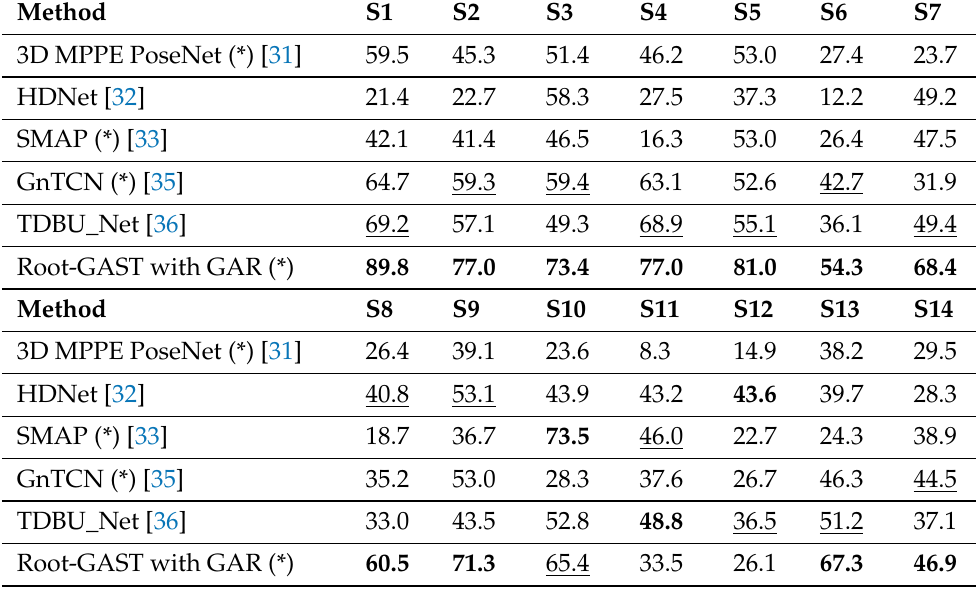
Table 2. Sequence-wise 3D-PCK abs comparison with the state-of-the-art on the MuPoTS-3D dataset. (*) The accuracies of methods are measured on matched ground truths. The best is in bold, the second best is